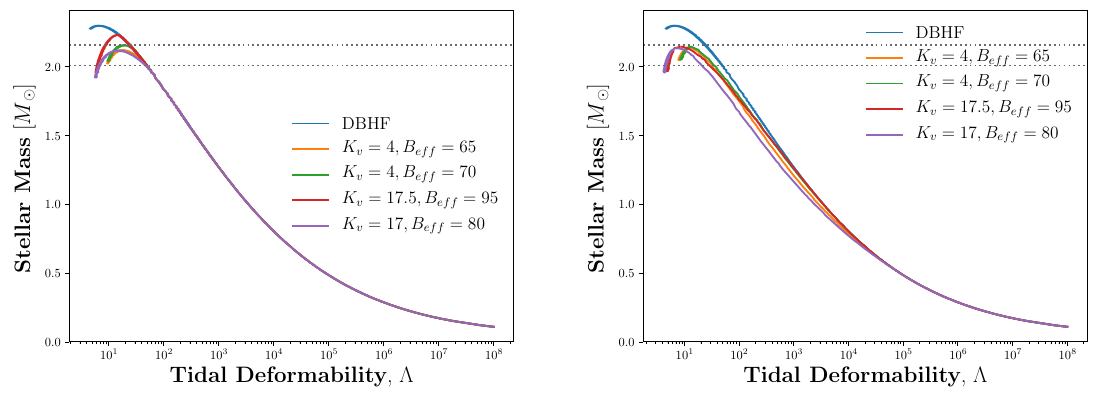
Figure 3. The Mass-Deformability curves for a component star obtained by solving Equations (5)–(13) for the various hybrid configurations. The image to the left displays the tidal behavior of Maxwell constructed hybrid models, while the one to the right does the same for Gibbs constructed